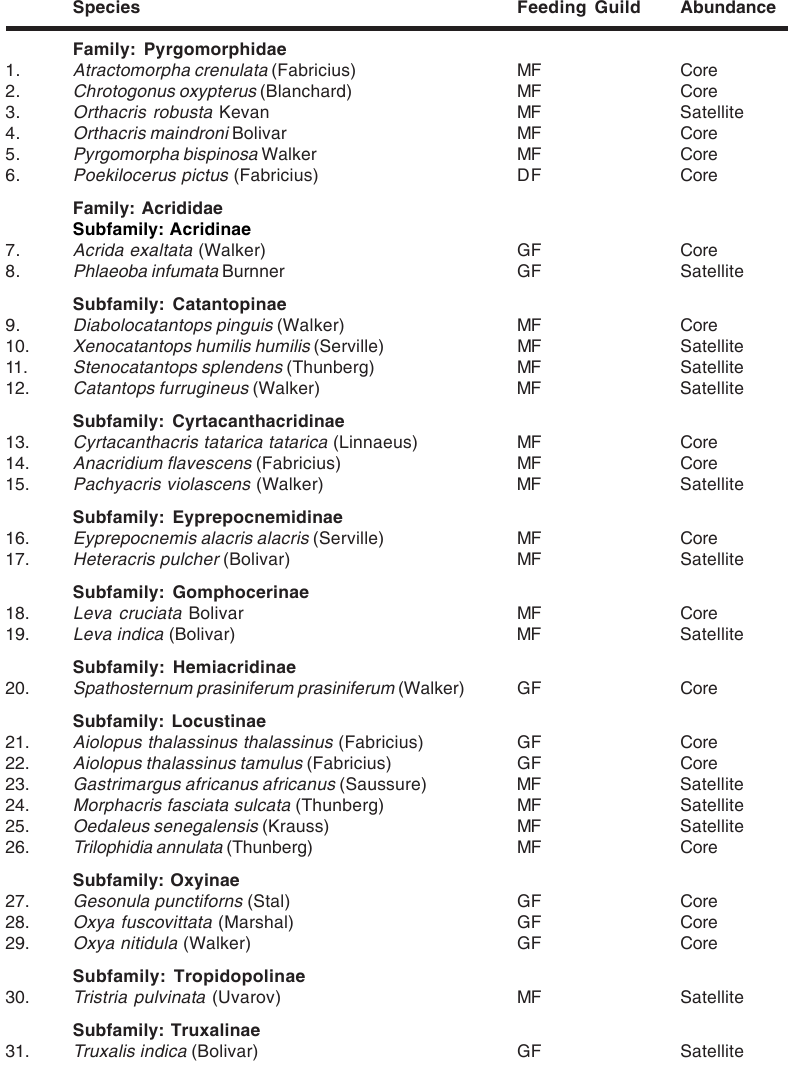
Table 1. Distribution, feeding guild and abundance of acridid species Species Feeding Guild